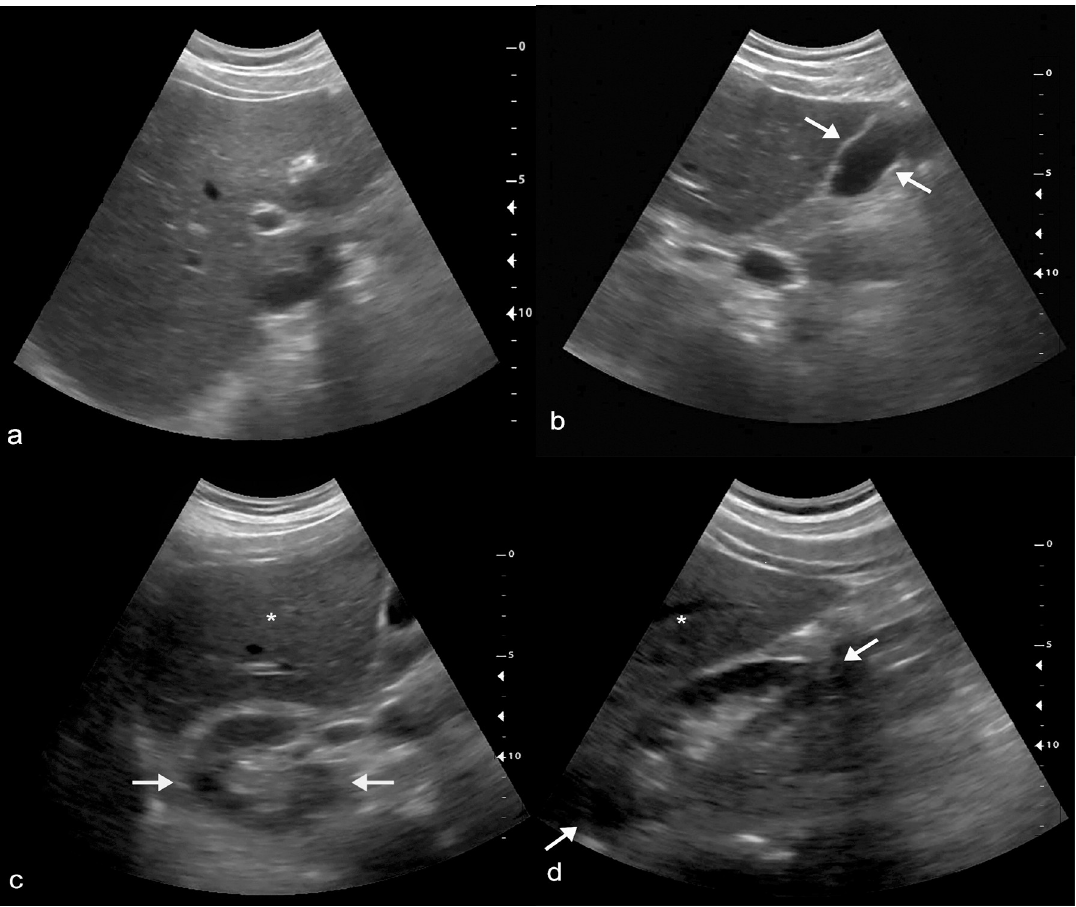
Fig 3. Normal RUQ VSI exam. (a) Normal liver identified on transverse VSI scan. (b) Normal gallbladder (arrows) identified on sagittal VSI scan. Transverse (c) and sagittal (d) images of the kidney (arrows) with partial visualization of the liver ( � ). S2 File includes the cine clips of this